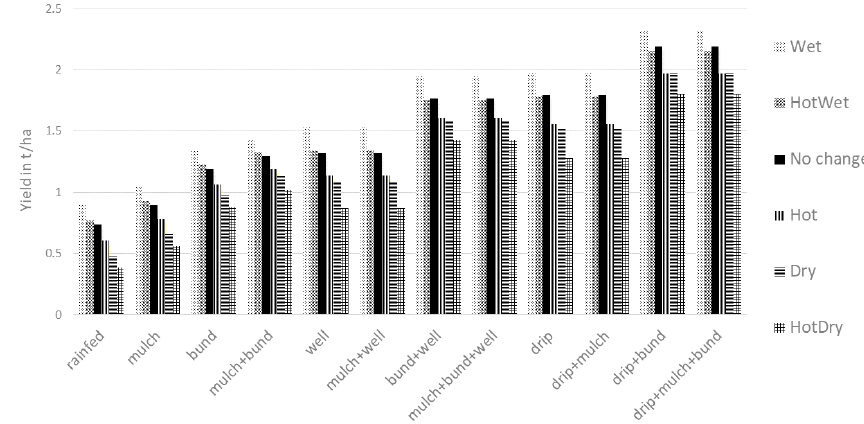
Figure 4. Average maize yield under different drought adaptation measures and different future climate scenarios.